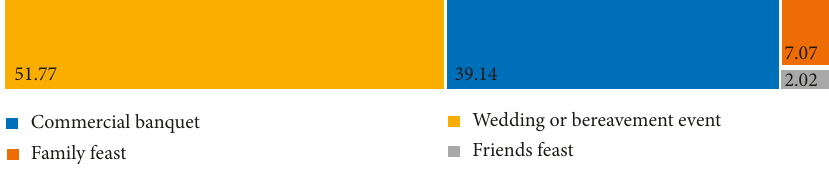
Figure 6: The most serious food waste banquet believed by